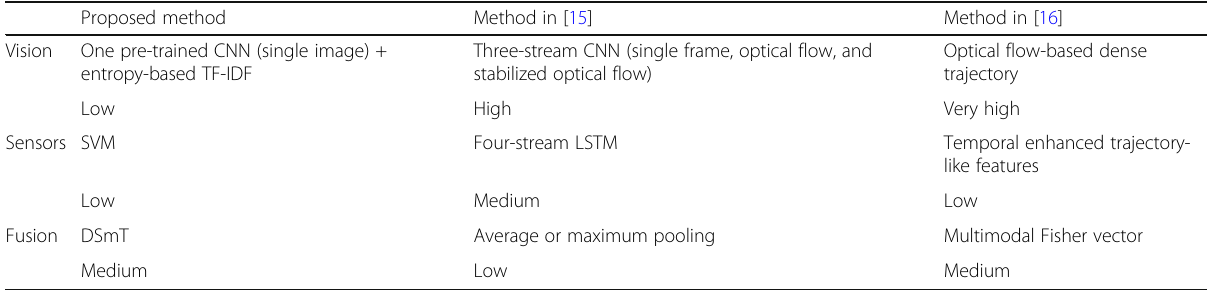
Table 12 Comparison of the complexity of different methods Proposed